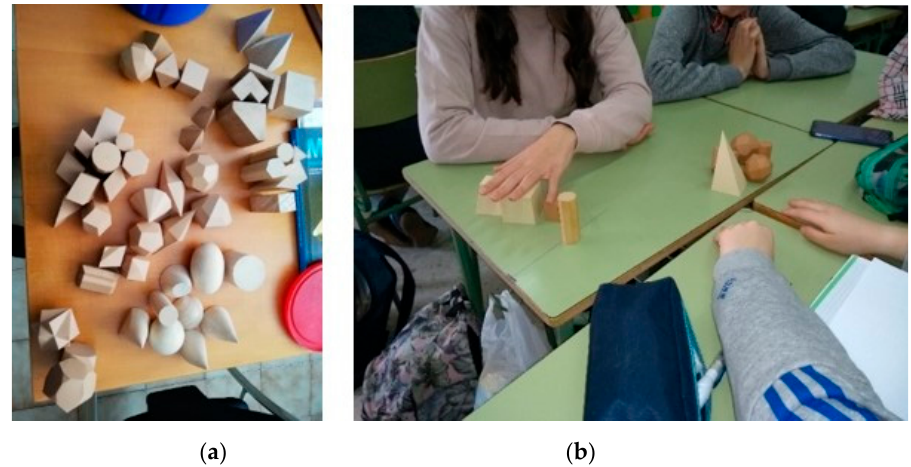
Figure 8. ( a ) student’s research works (origami, 3D draws); ( b ) student’s research work (video game quiz in Genially).